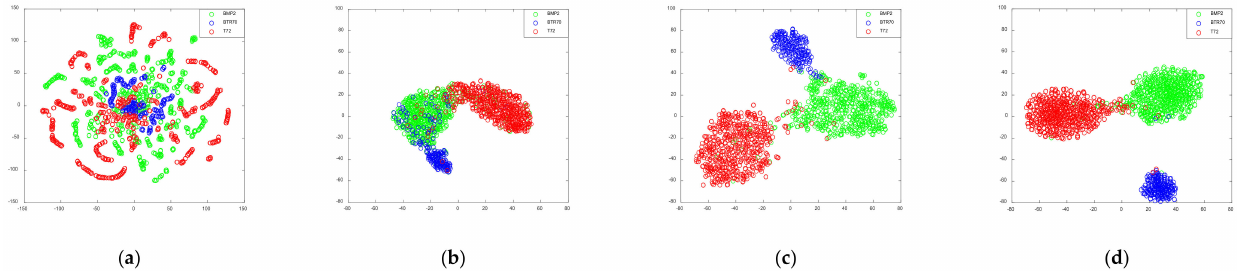
Figure 9. T-SNE visualization of the learned features for ( a ) the original amplitude feature, ( b ) the VAE model, ( c ) LightNet, and ( d ) the proposed fusion